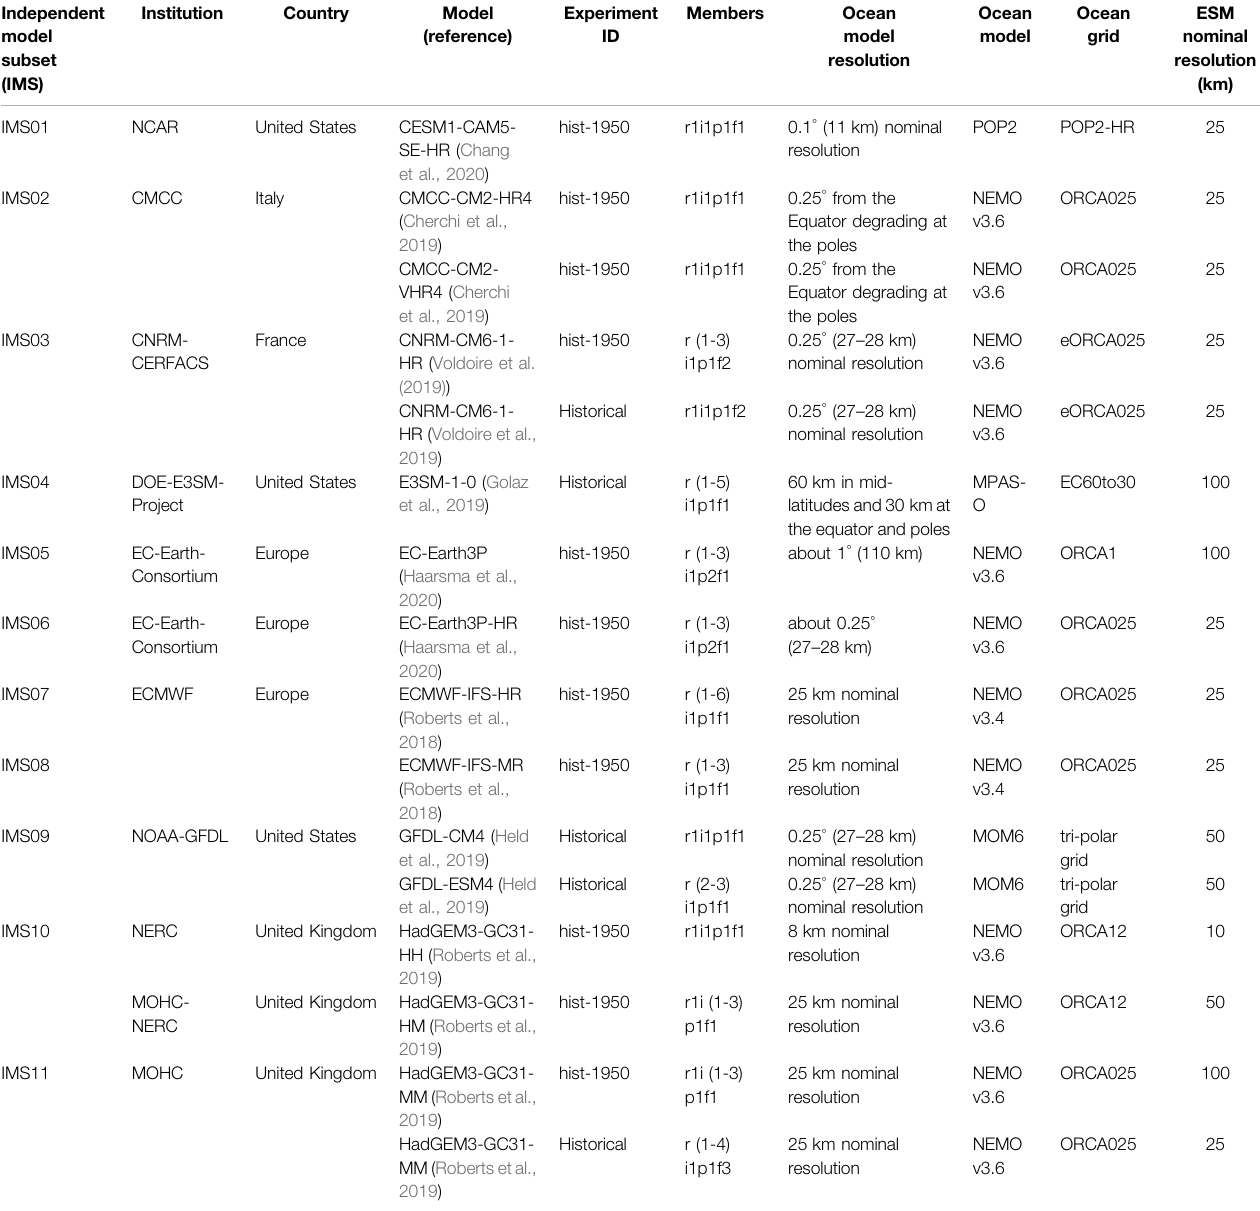
TABLE 1 | Independent model subsets based on institutional democracy and using ocean grid as a secondary criterion when applicable. Independent